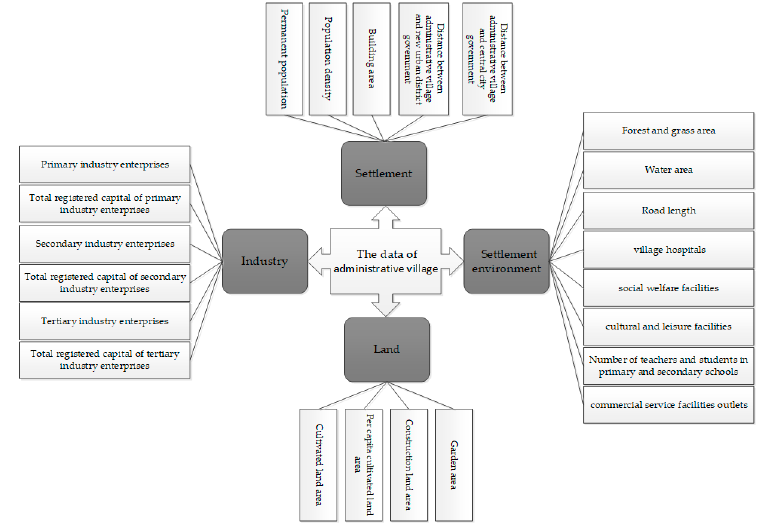
Figure 2. Data of the administrative village used in this study.